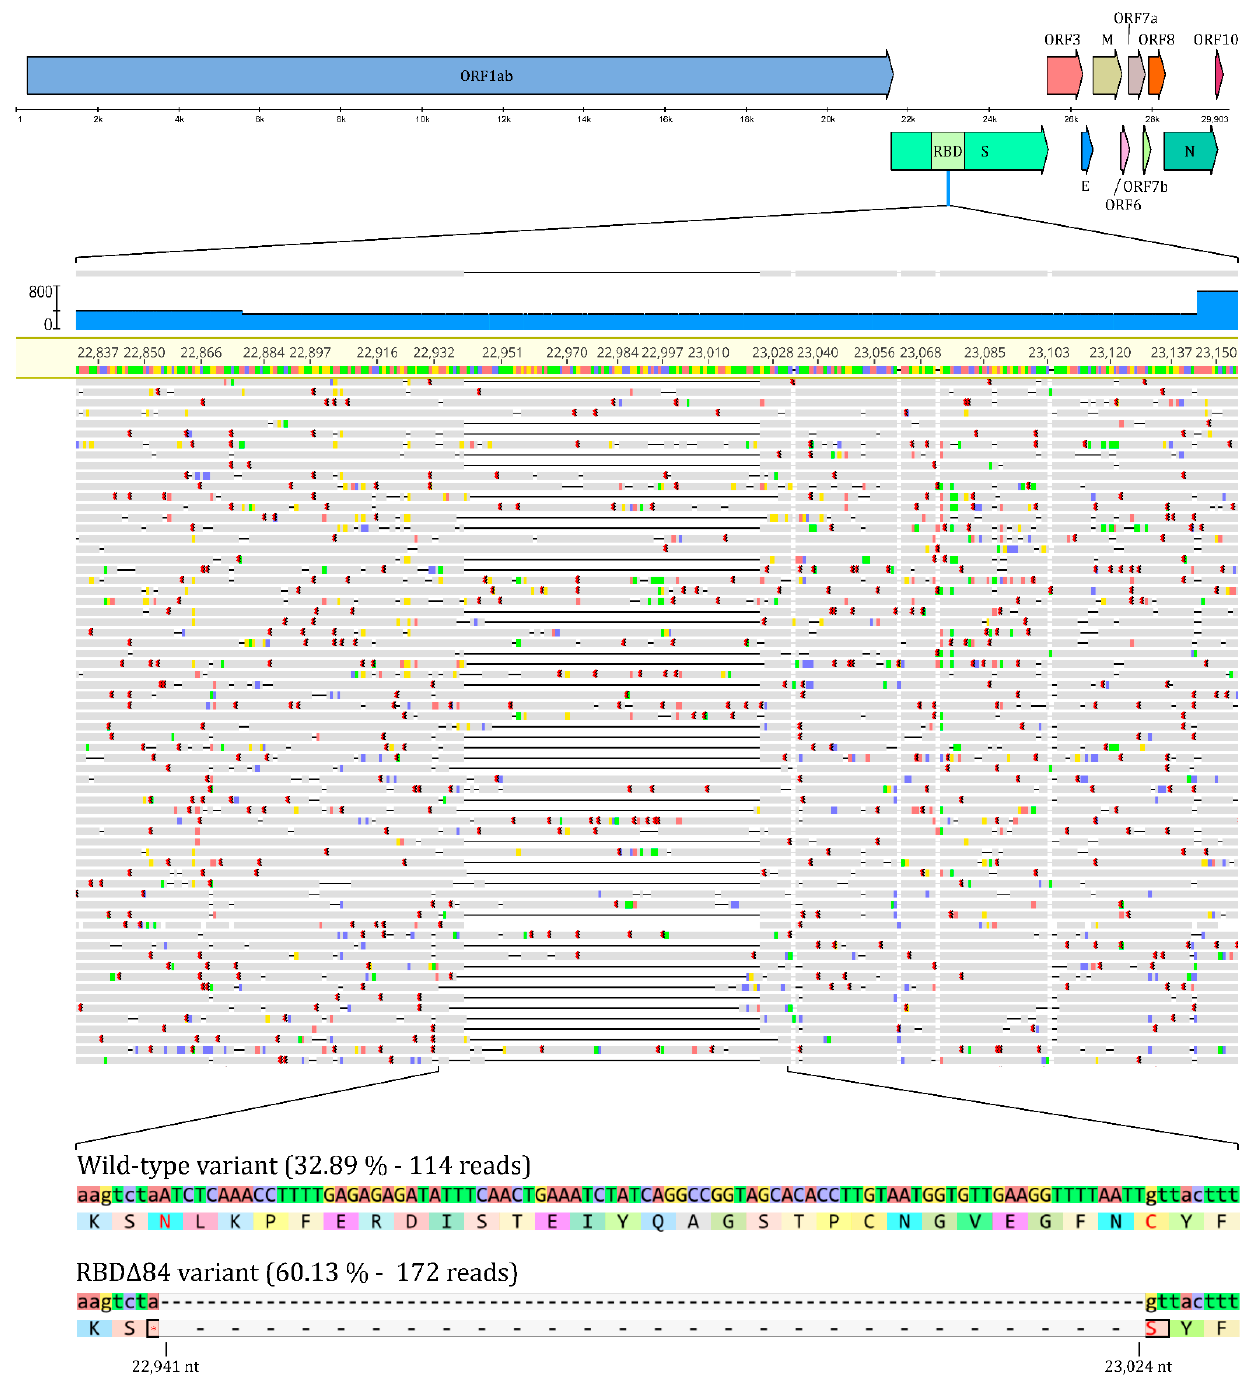
Figure 1. Representation of the deletion and its position within the SARS-CoV-2 genome, along with raw NGS sequencing data of the region of interest. The figure highlights the deleterious region and provides the quantitative ratio of the two variants during co-infection. Wild-type variant refers to the non-deleterious, whilst RBD ∆ 84 to the deletOrious variant. Visualization was partially performed in Geneious Prime 2020